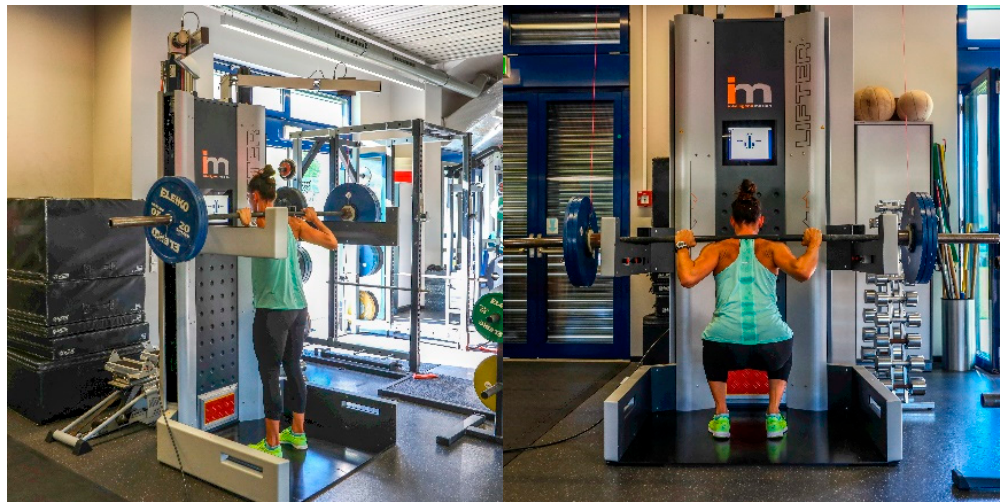
Figure 3. The present IML model: squat top position and squat bottom position.